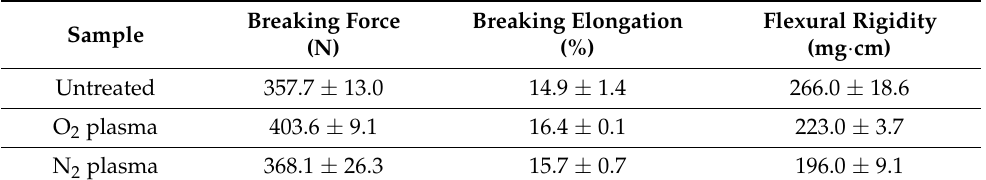
Table 1. Breaking strength (N) and elongation (mm) and flexural rigidity (mg · cm) of untreated and plasma-treated samples.